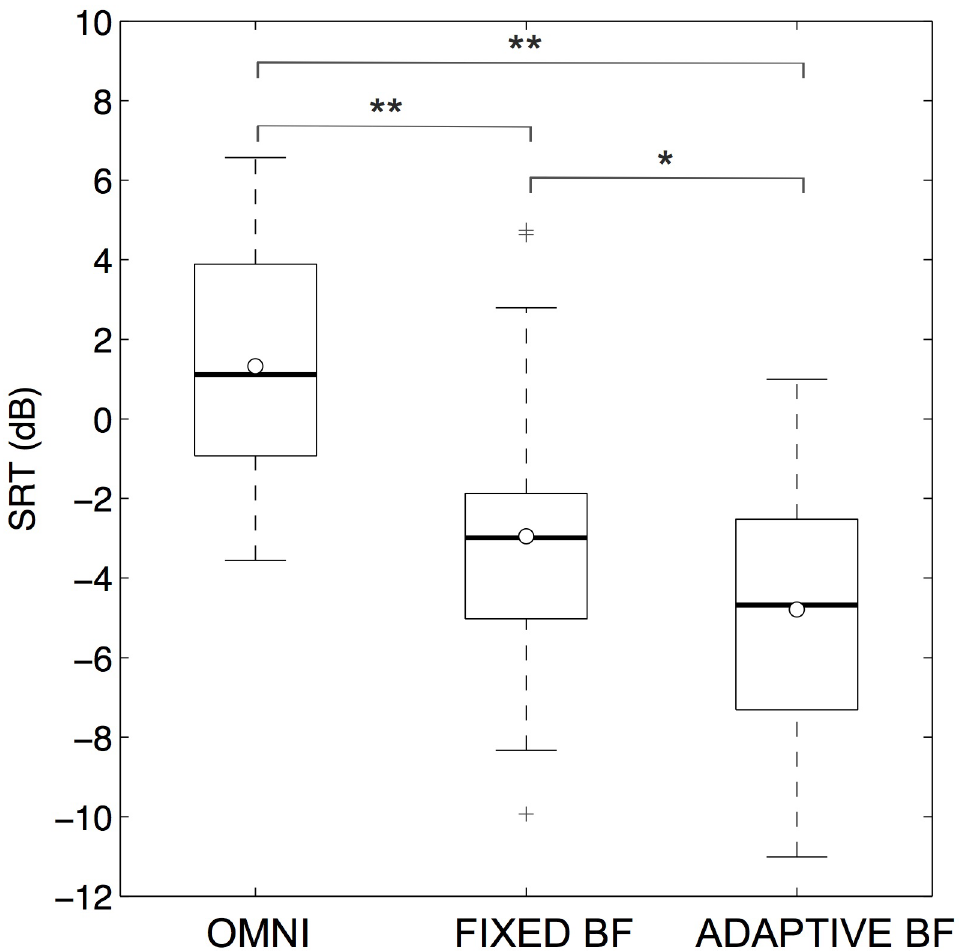
Fig 3. SRTs. MeasuredSRT (dB) for omnidirectional setting, fixed beamformer setting and adaptive beamformer setting. * indicatesp = 0.001; ** indicatesp < 0.0001.